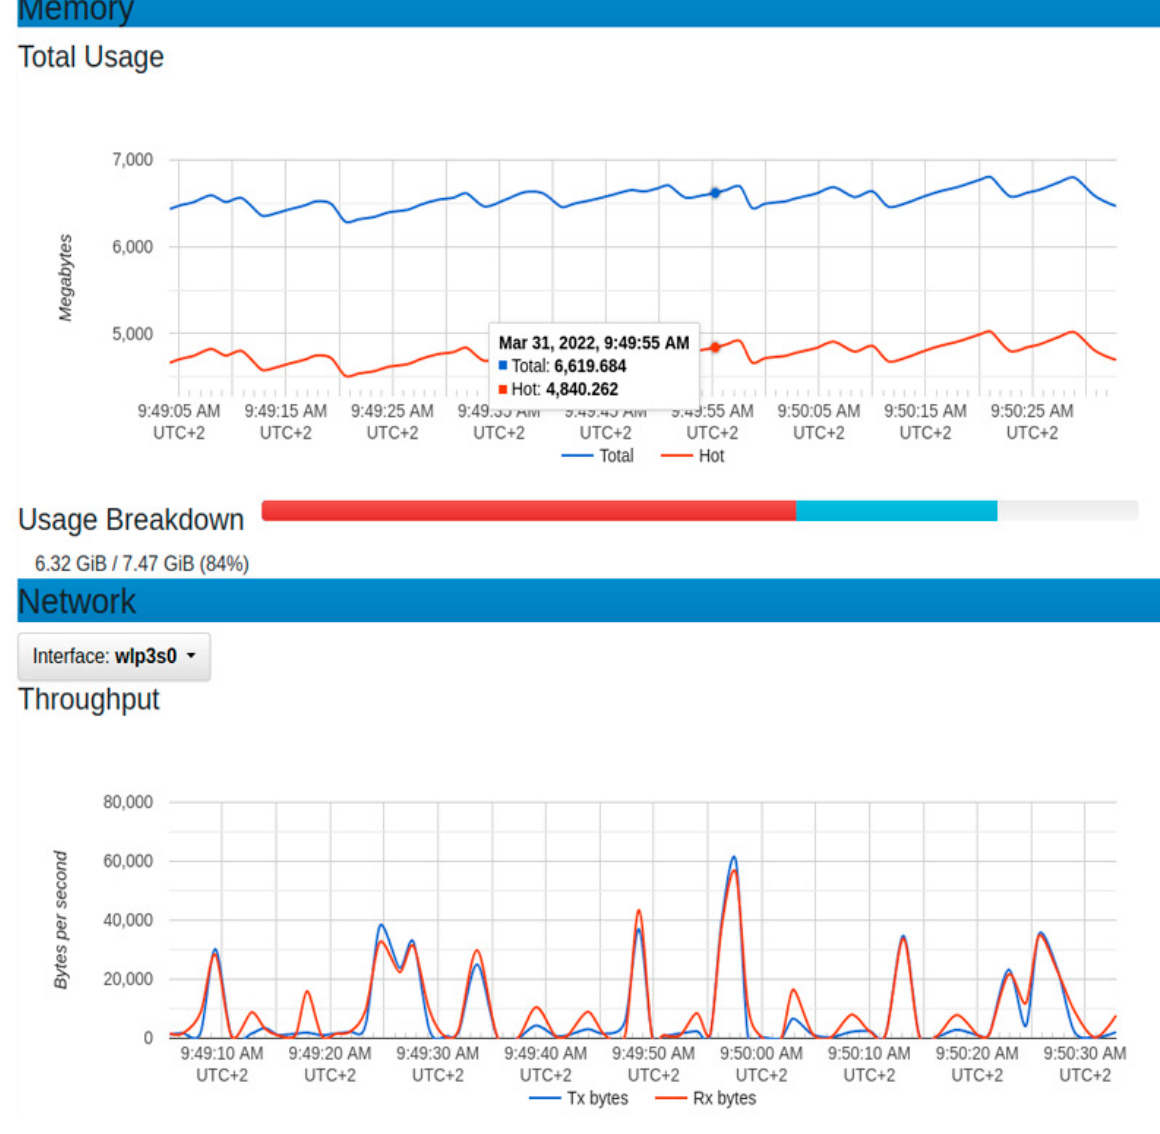
Figure 17. CPU resource with 1,000,000 generated sensor requests.